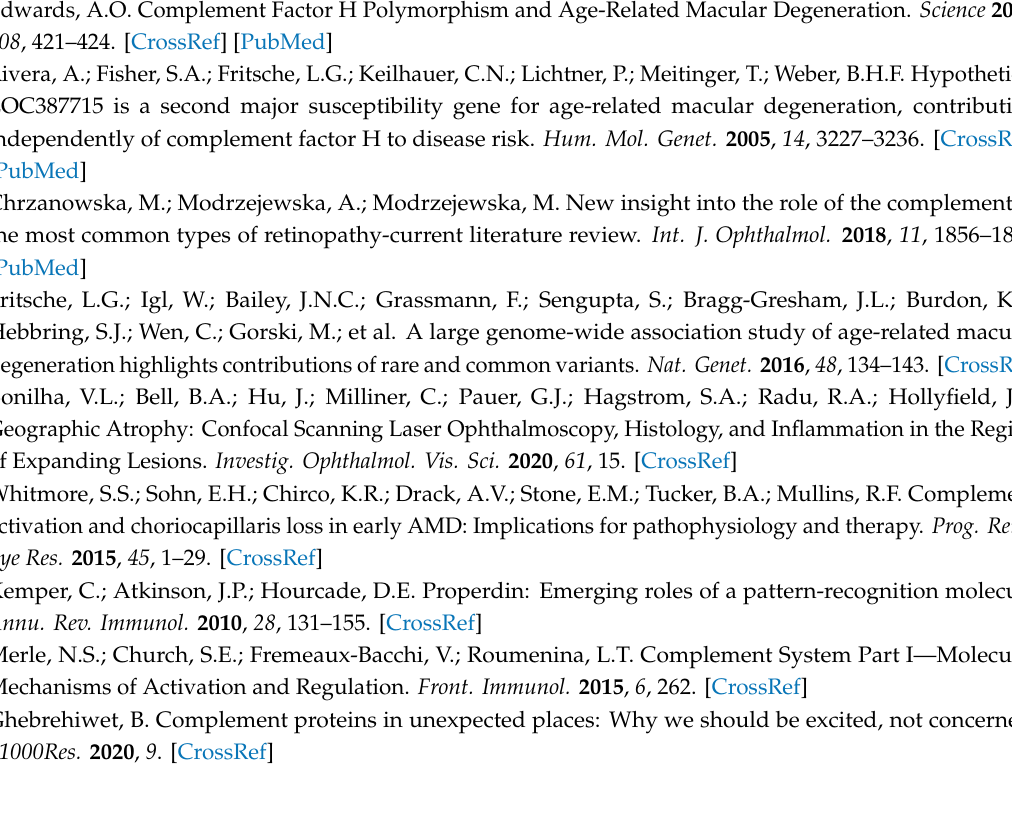
Figure S1: Ex vivo cultivated human hpRPE cells were pigmented and vital for 14 days on transwell filters, Figure S2: Western Blots of C3a and C5a in hpRPE cells, Figure S3: Complement component secretion is di ff erent in hpRPE cells from left and right donor eyes, Table S1: In-house designed RT-qPCR and PCR primers, Table S2: QuantiTect PrimerAssays